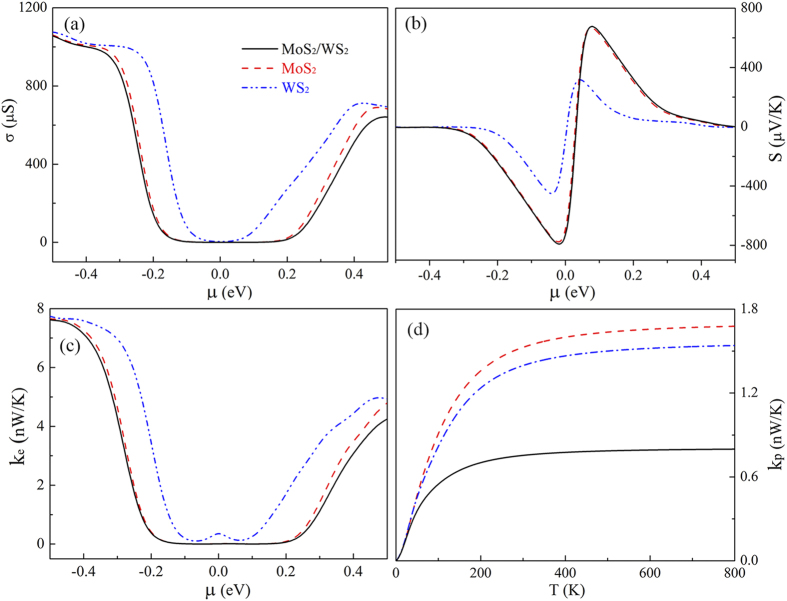
(a) σ, (b) S, and (c) ke of MoS2/WS2 (N = 1), MoS2, and WS2 nanoribbons as a function of chemical potential , respectively, at T = 300 K. (d) kp of MoS2/WS2 (N = 1), MoS2, and WS2 nanoribbons as a function of temperature T.